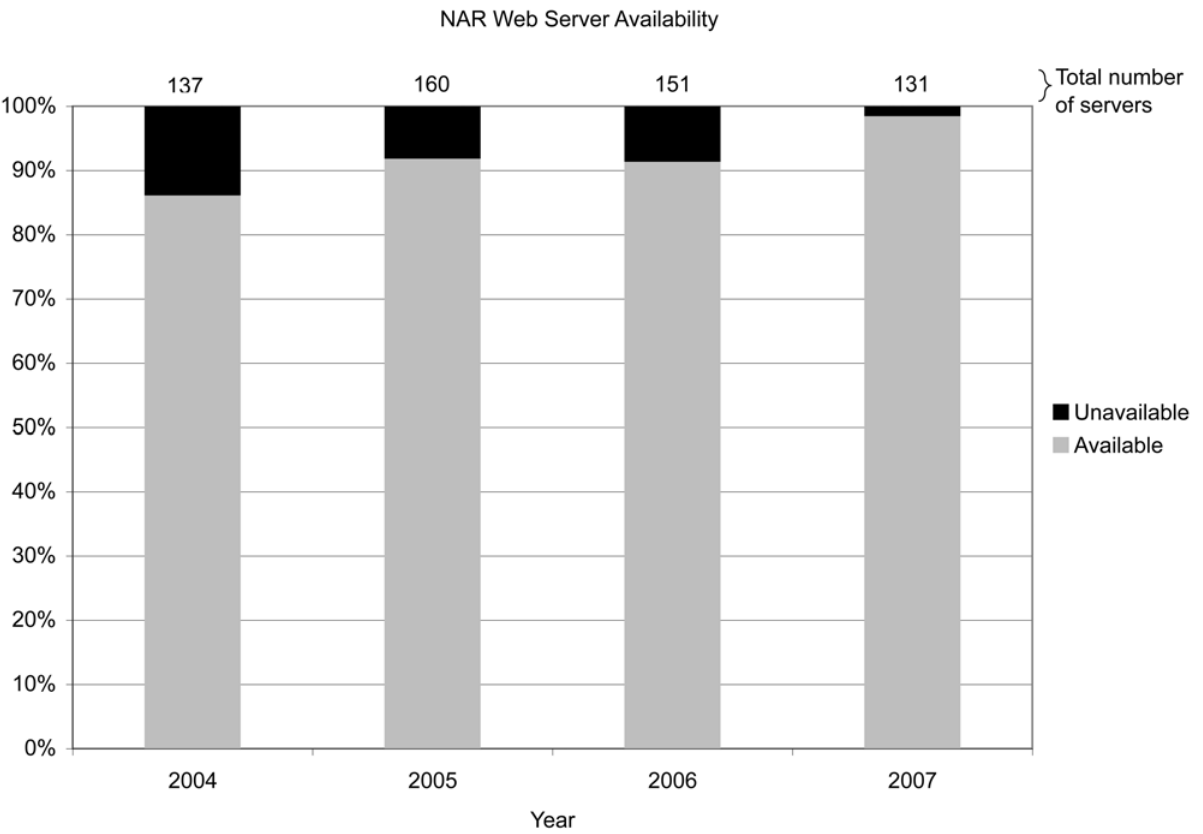
Figure 1. NAR Web server availability.